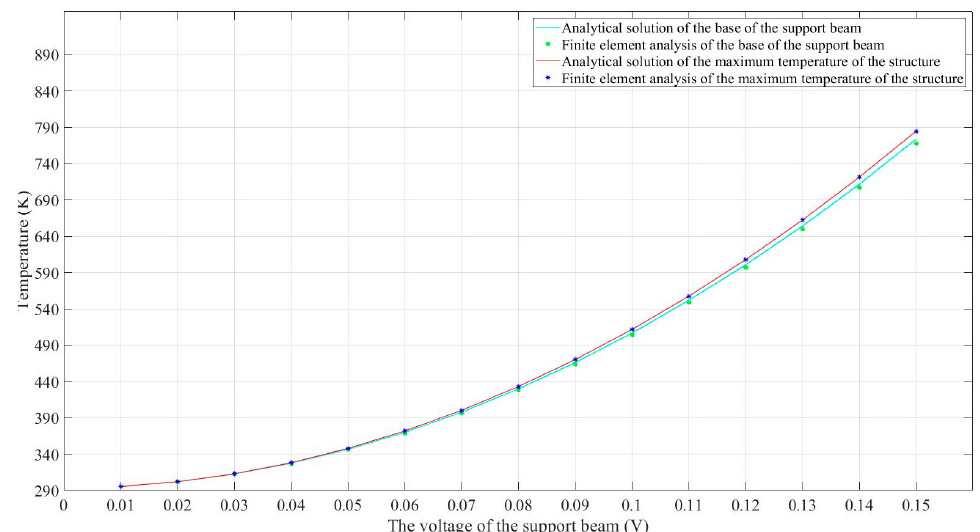
Figure 7. Comparison of analytical solutions and FEA results when different voltages were applied.